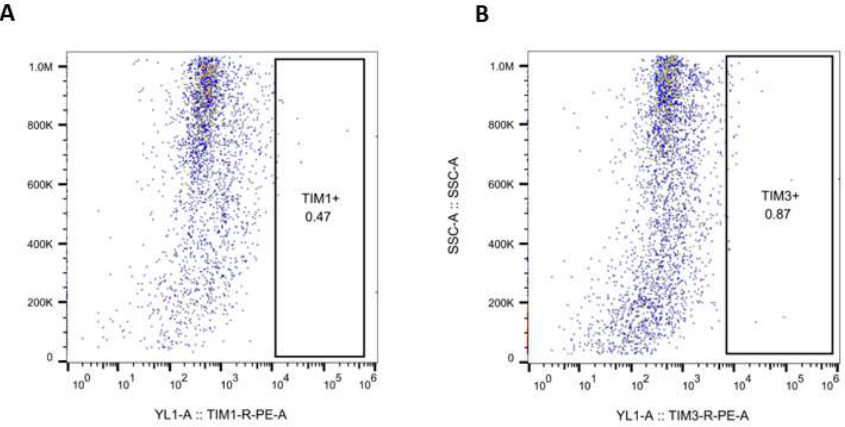
Figure A2. Cells do not express TIM family protein receptors. Flow cytometric measurement of ( A ) TIM1, ( B )